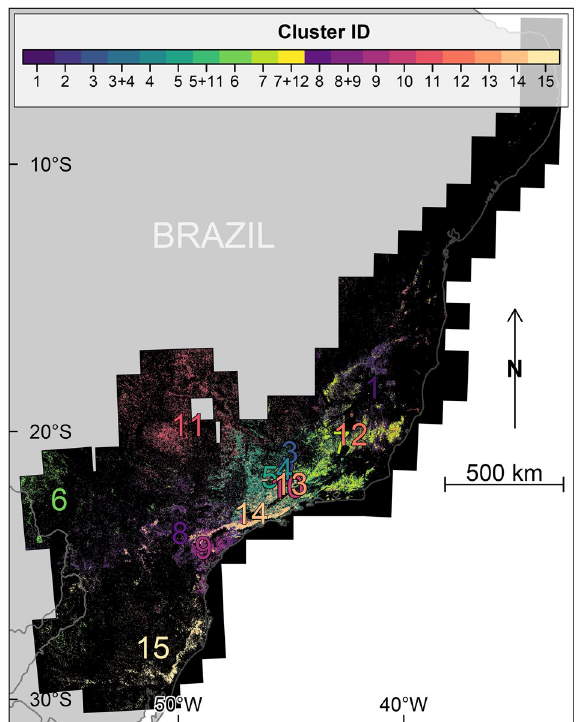
Figure 9. Map of the 15 clusters obtained by K-means clustering of flowering dates (start, peak and end) and detection coordinates. A pixel can belong to two clusters if it has two flowering peaks. The more frequent combinations, represented by more than 1000 pixels, are also given (3 and 4 for example). The cluster ID numbers are located at the centroid of each